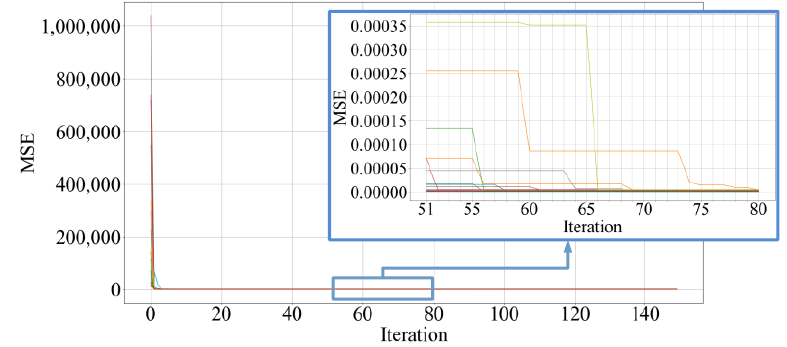
Figure 13. Convergence curves for 24 h for the WOA method. Each plot contains 24 (hourly) optimization curves. In order to easily observe the convergence characteristics, the curves for the 51st to 80th iterations are magnified. The respective convergence average MSE values for PSO, SSA, and WOA are 8.89 × 10 − 8